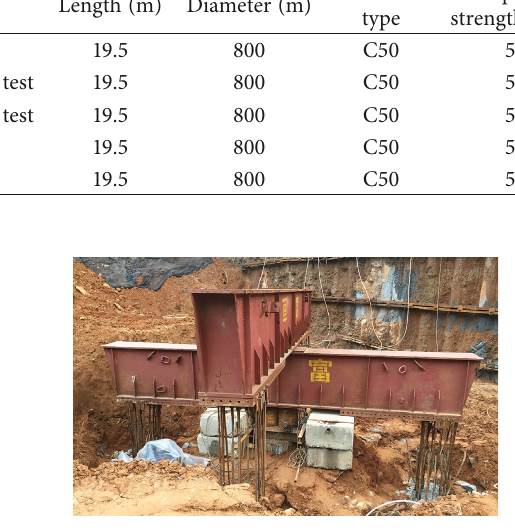
Figure 3: Compressive SLT setup.